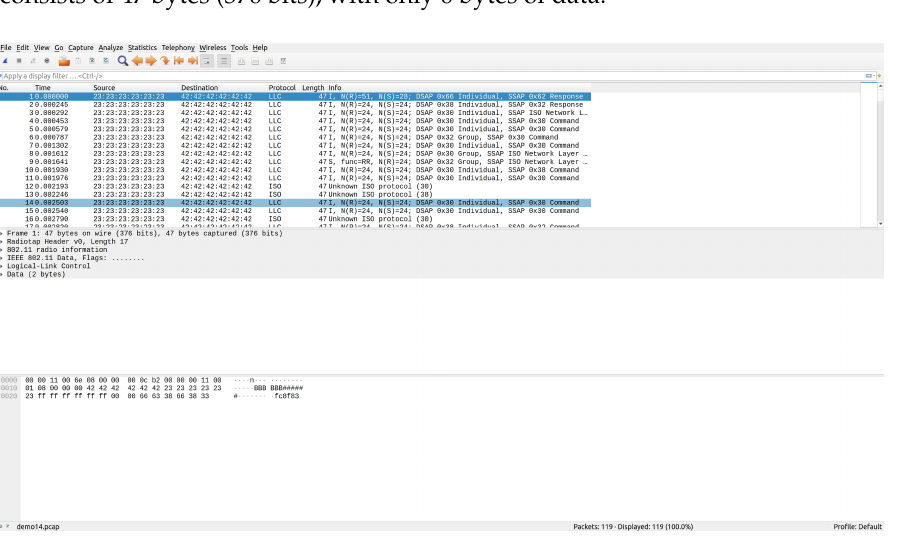
Figure 24. IEEE 802.11p messages received in Wireshark.